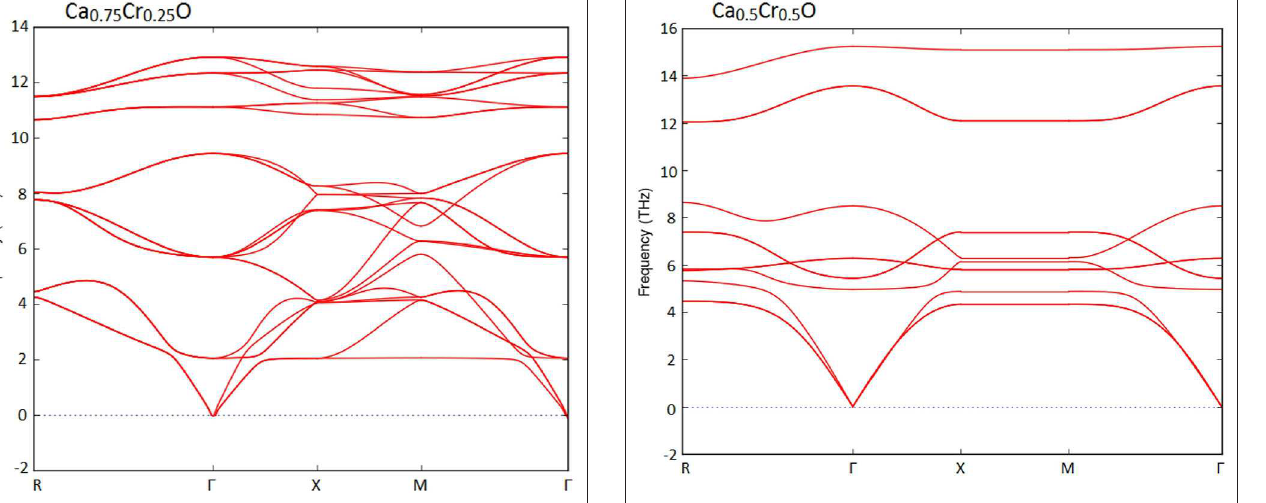
FIGURE 1 | Phonon spectra for Ca 0.75 Cr 0.25 O.